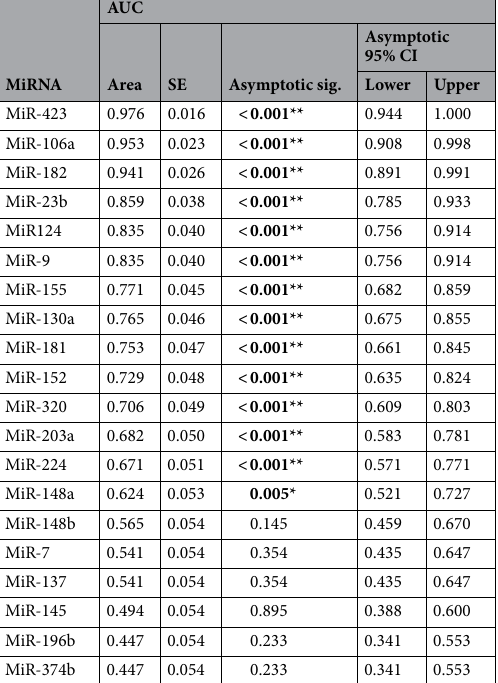
Table 4. ROC analysis for biomarker accuracy testing of circulating miRNAs understudy. Significant P values are in bold. *Significant at p value < 0.05, **Significant at p value < 0.01. AUC area under the curve, SE standard error. AUC: 0.5 or less = no discrimination, 0.7–0.8 = acceptable discrimination, 0.8–0.9 = excellent discrimination, and more than 0.9 = outstanding discrimination. SE standard error, Sig significance. Significant values are in